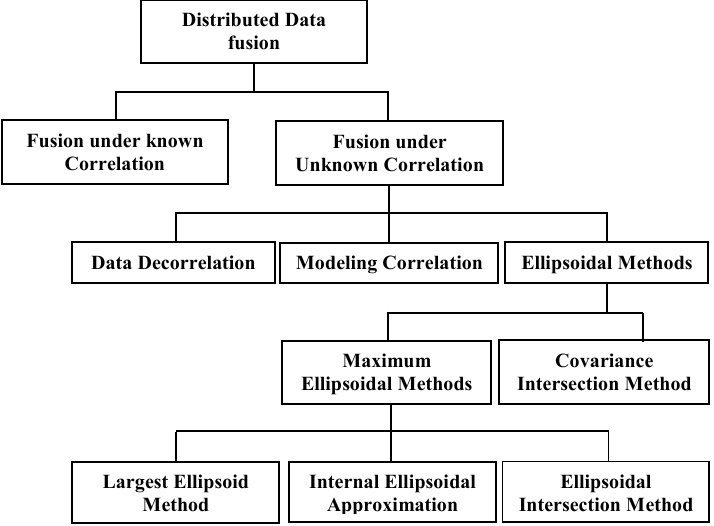
Figure 6. Taxonomy of Fusion under Unknown Correlation.